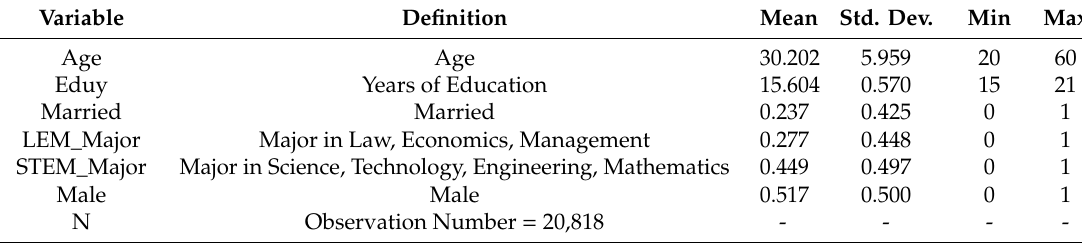
Table A3. Definition and summary statistics of personal